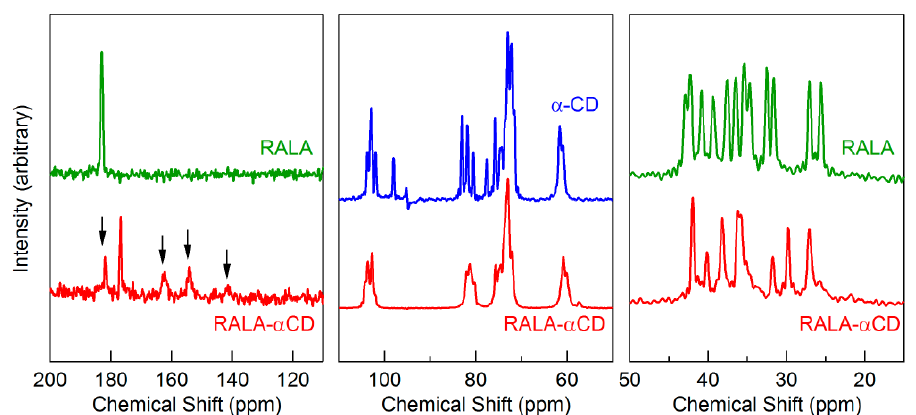
Figure 2. 13 C-CP/MAS NMR spectra of the crystalline R(+)- α -Lipoic Acid (RALA)- α CD complex, free α -CD, and free RALA, recorded at 6 kHz spinning frequency. The arrows indicate the spinning side bands Adapted from [18], licensed under CC BY 4.0. [18].